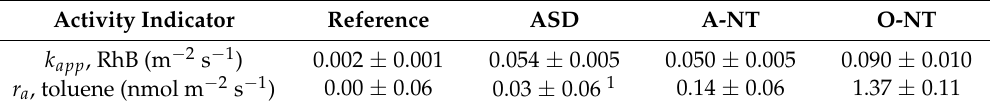
Table 2. Photocatalytic activity in gas and liquid phase for samples produced in different